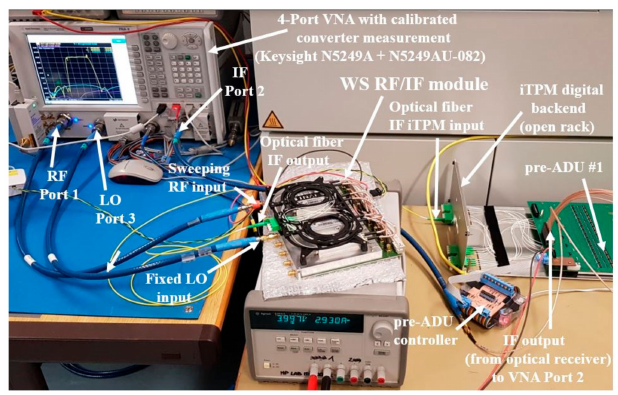
Figure 22. Testing of one of the WS RF / IF boards with the IFoF links. The RF port of the VNA is connected to channel 1 of the board. The IF signal is extracted from the MCX connector at the output of the optical receiver, located inside the pre-analog to digital unit